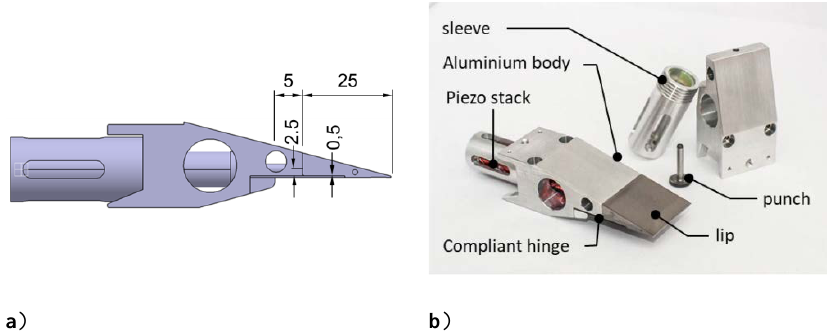
Figure 7. Final dimensions and design of an actuated lip segment: ( a ) CAD model with essential dimensions; ( b ) Realized functional model.